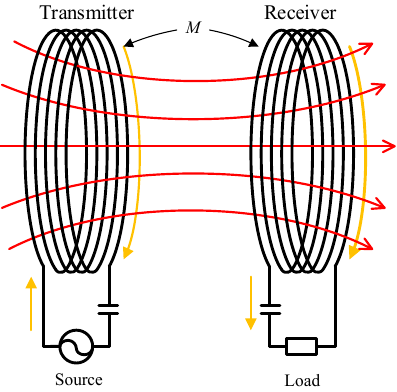
Figure 1. The inductive coupling wireless power transfer (WPT)